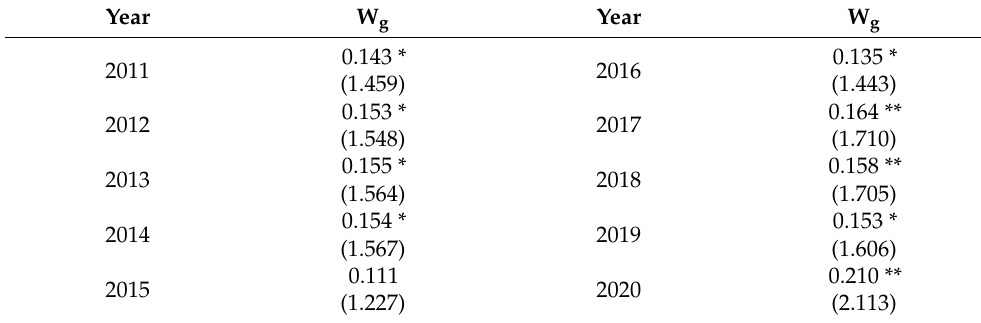
Table 9. Global spatial